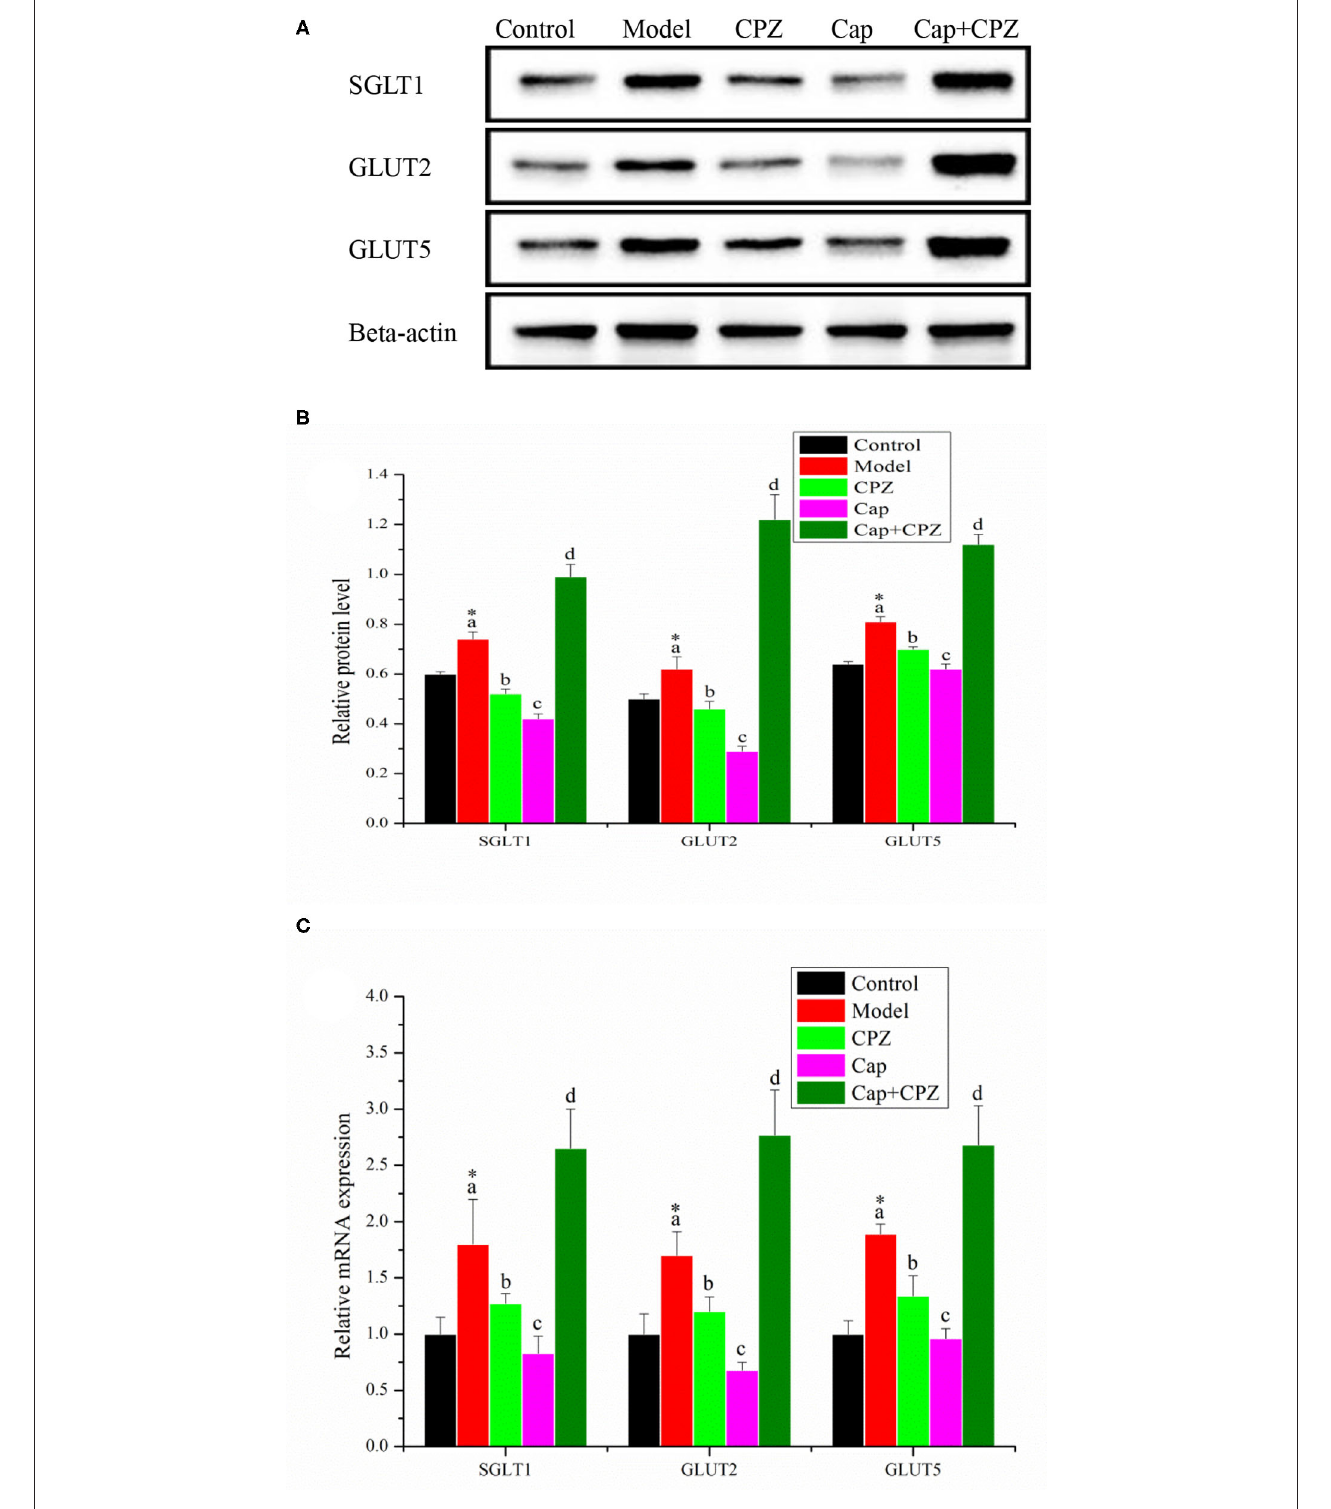
FIGURE 6 | Effects of TRPV1 receptor antagonist and capsaicin on protein (A,B) and mRNA (C) expression levels of key genes for glycometabolism in ileum of STZ-induced diabetic rats. All data are expressed as means ± SD, n = 8. *Means are significant difference compared with the control group ( P < 0.05). Means with different superscript letters are significantly different among the diabetes groups ( P < 0.05). SGLT1, sodium/glucose cotransporter 1; GLUT2, glucose transporter 2; GLUT5, Glucose transporter 5. Effective concentrations of capsaicin and capsazepine are 6 and 10 mg/kg · BW, respectively.